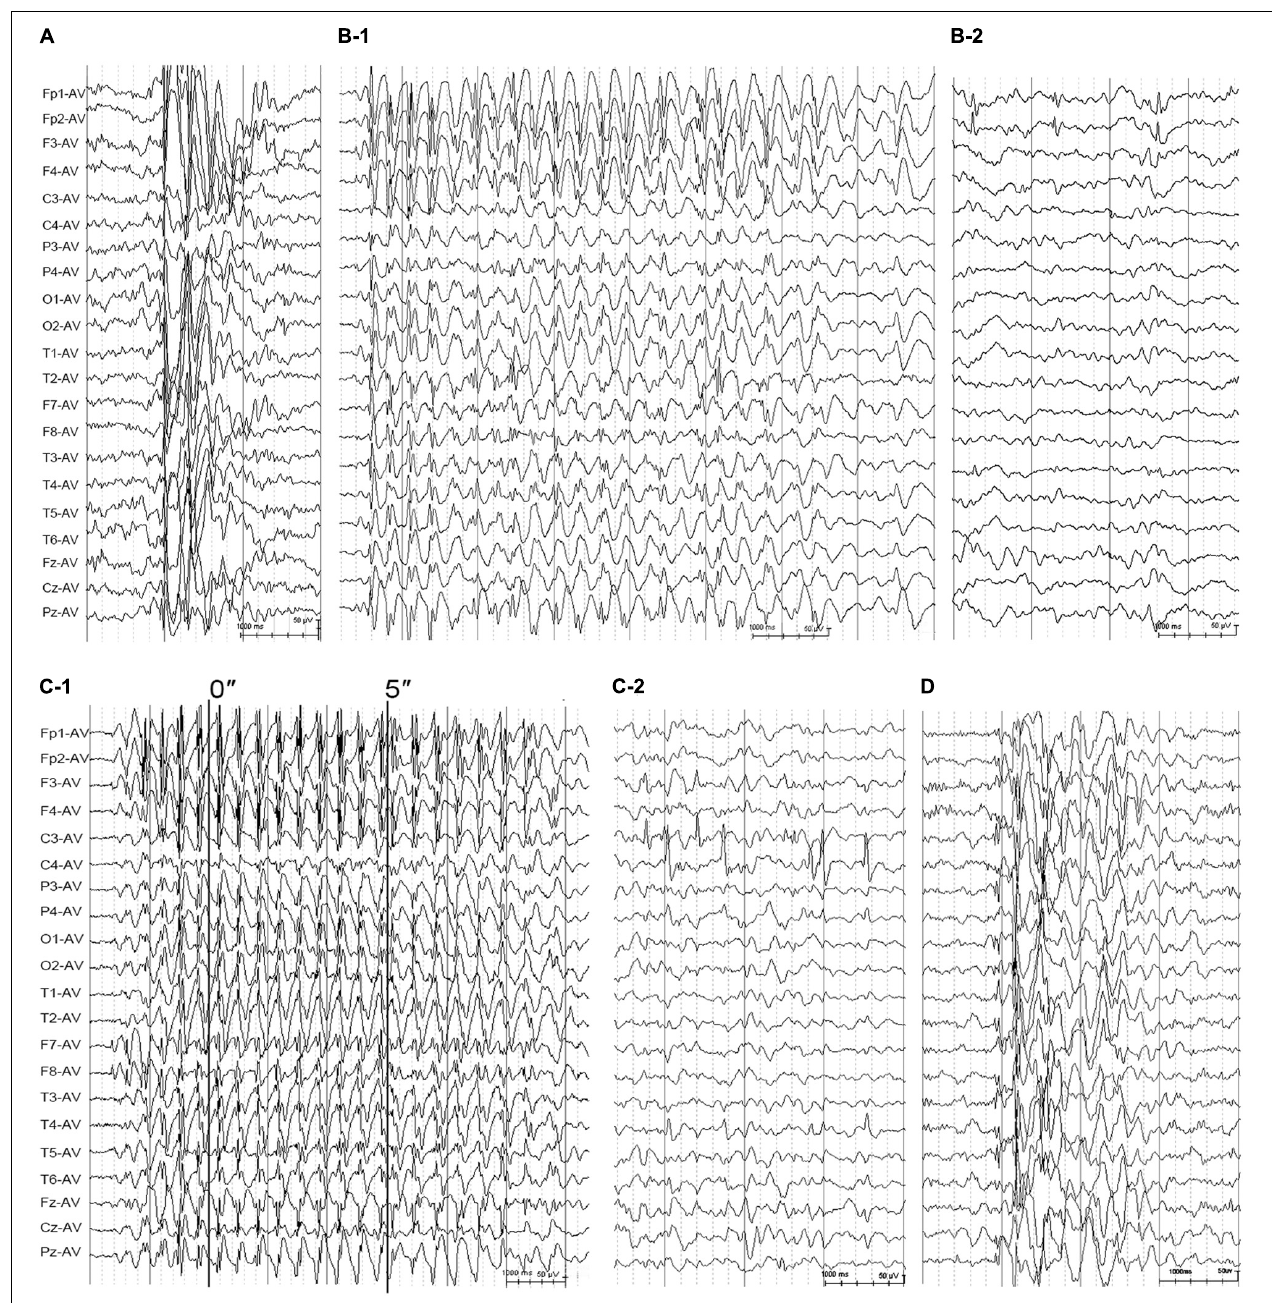
FIGURE 3 | Electroencephalogram changes in the cases with idiopathic generalized epilepsy with GRIN2A mutations. (A) Interictal EEG for the patient with juvenile myoclonic epilepsy with mutation K590N obtained at the age of 14 years showed high-voltage generalized 3.5 Hz polyspike-and-waves. (B) Interictal EEG for the case with juvenile absence epilepsy with mutation K879R obtained at the age of 13 years showed 3–3.5 Hz spike- and -waves (B-1) and interictal bilateral frontal focal spikes (B-2) . (C) EEG for the patient with CAE with mutation R1067W obtained at the age of 5 years. The ictal EEG showed regular high voltage 3–3.5 Hz spike- and -waves with typical absence seizure (C-1) . The interictal EEG showed bilateral centro-temporal spikes during sleep (C-2) . (D) The interictal EEG of the patient with unclassified IGE with mutation R1067W obtained at the age of 3 years showed irregular spike-and-waves. EEG, electroencephalogram.